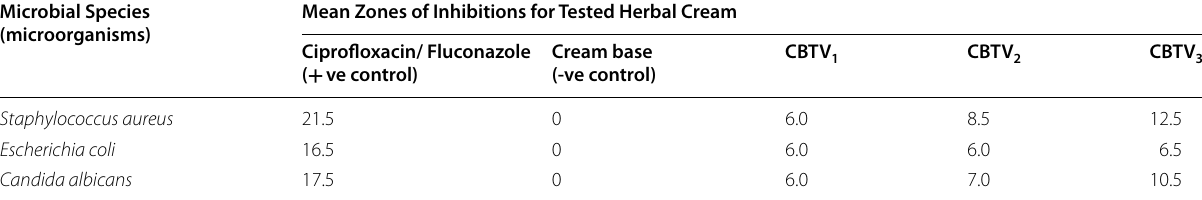
Table 3 In vitro antimicrobial activity for the tested cream samples Microbial Species